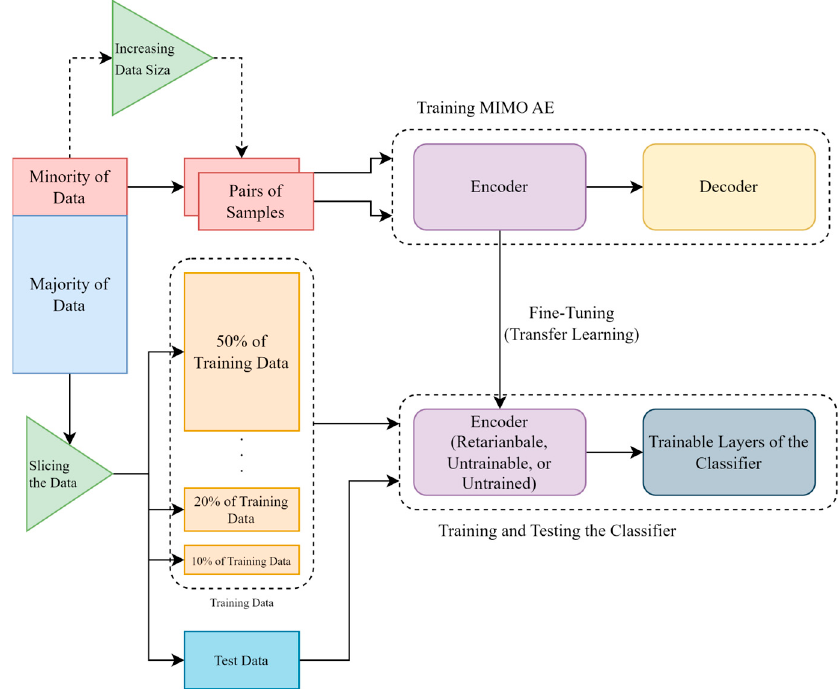
Figure 11. A block diagram of the proposed methods.